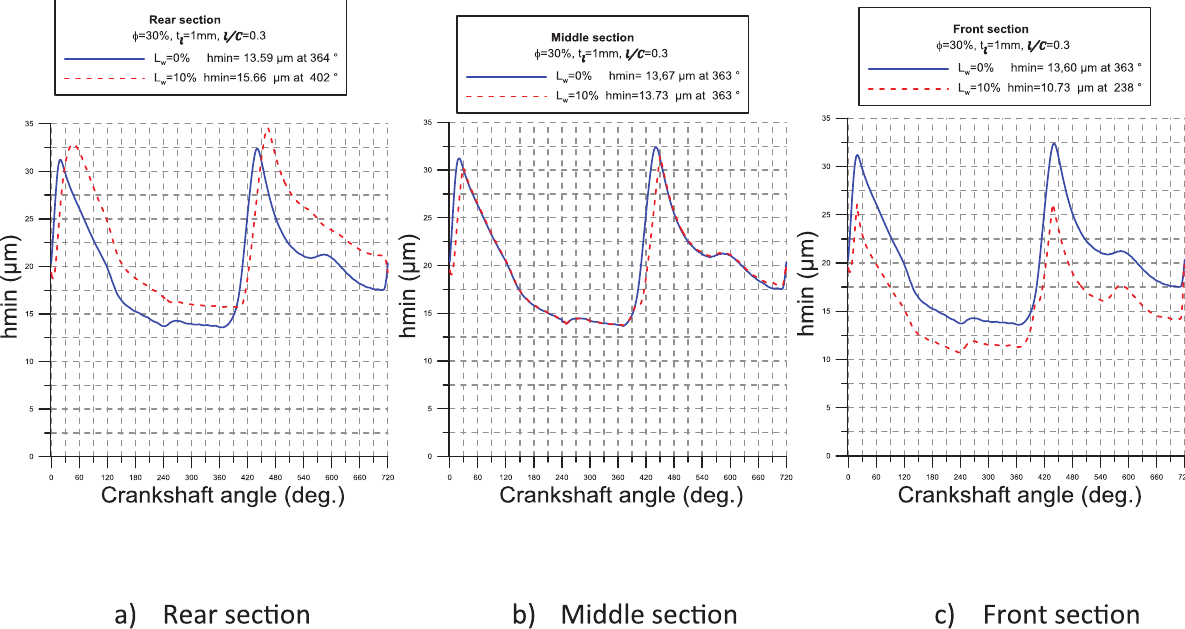
Fig. 10. Effects of the dynamic misalignment parameter L W on the minimum fi lm thickness over an engine cycle for the non- Newtonian